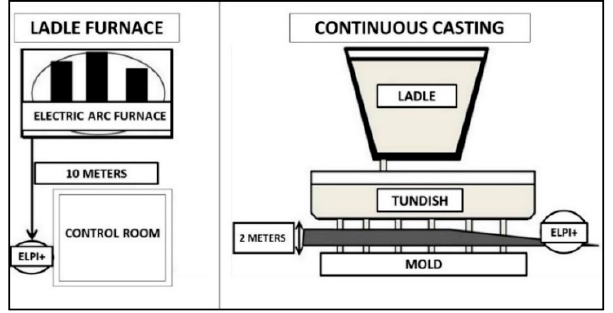
Figure 1. Schematic diagrams of the indoor sampling sites in the steel foundry: Ladle furnace sampling site ( left ) and continuous casting sampling site ( right ).